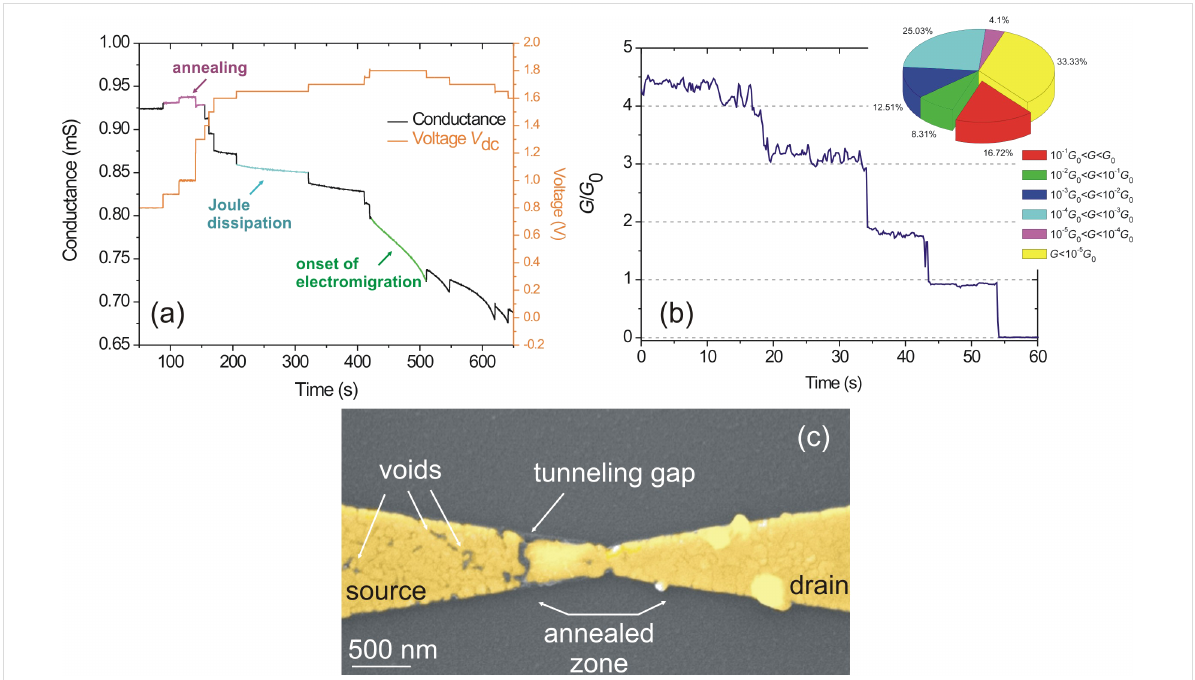
Figure 2: (a) Temporal extract of the electromigration sequence featuring the effect of partial annealing, Joule heating and onset of electromigration on the evolution of the condutance with bias increments. (b) Time trace of the conductance G ( t ) during the last moments of the electromigration process. The conductance is quantized in units of G 0 , the quantum of conductance. Inset: statistics on the final conductance for a series of 24 electro- migrated constrictions. (c) False-color scanning electron micrograph of the device after electromigration. The tunneling junction forms on the source electrode. The zone corresponding to the constriction has been annealed by Joule dissipation during the process, reducing the number of grain boundaries available to trigger electromigration. Voids resulting from Au migration are also observed on the source electrode. The image is obtained by sputtering a thin conductive Au layer on the post mortem